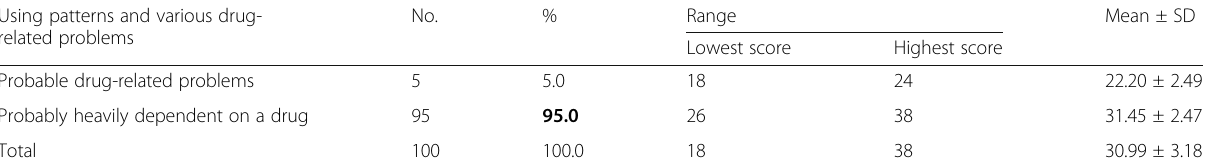
Table 3 Distribution of using patterns and various drug-related problems among SUD patients ( n = 100) according to Drug Use Disorder Identification Test Using patterns and various drug- related problems